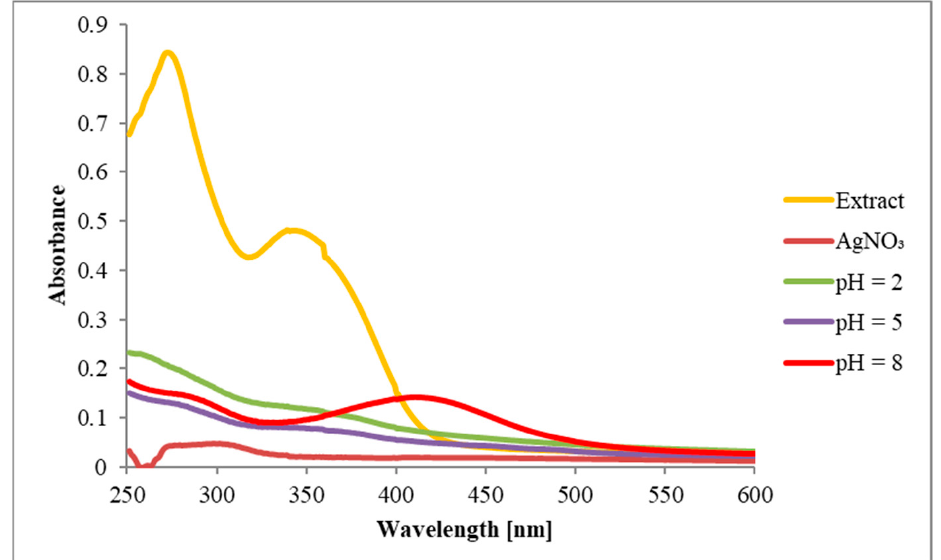
Figure 6. The influence of pH (2, 5, and 8) on AgNPs-EtOH formation.